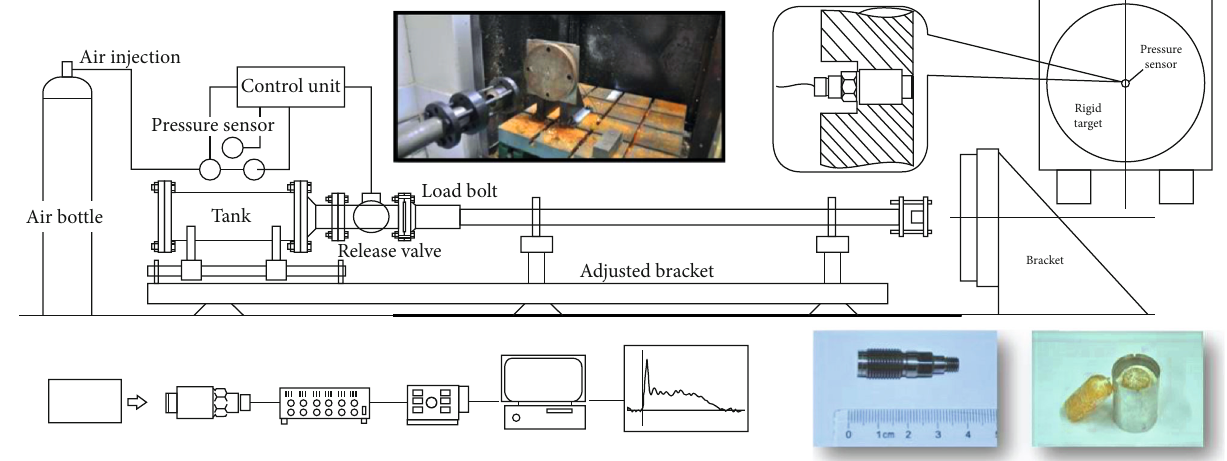
Figure 6: Experiments and analytical studies of gelatin arti fi cial bird impact rigid target. Table 5: Undetermined coe ffi cient of the bird ’ s EOS. Parameter